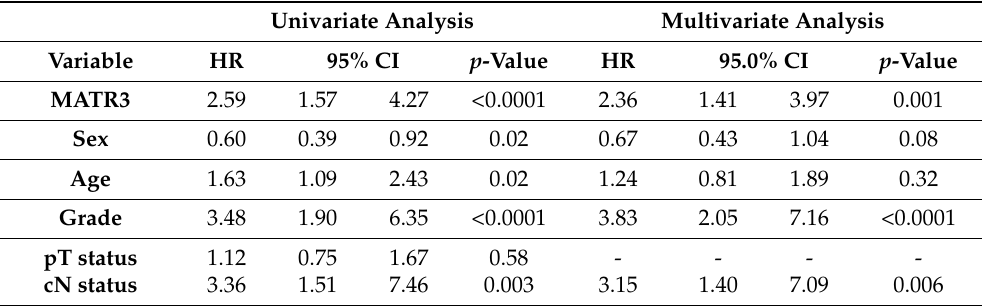
Table 2. Univariate and multivariate analyses of prognostic factors in our own cohort by the Cox proportional hazard model. “-” indicates variable was not included in multivariate